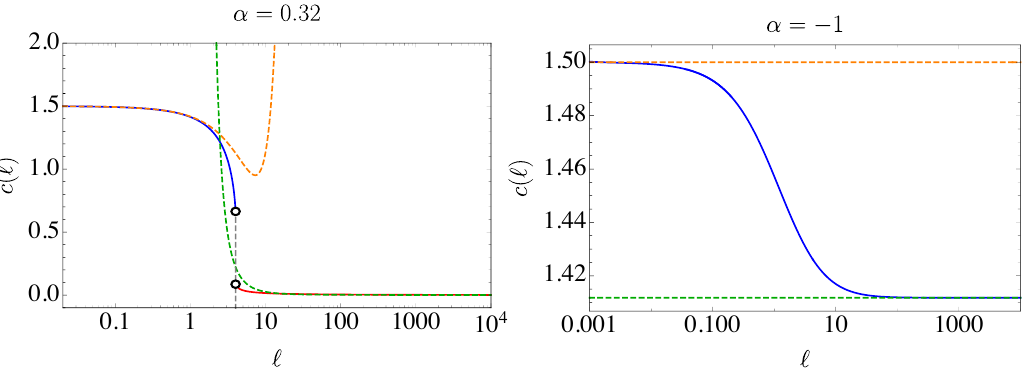
Figure 4 . Left plot: Casini-Huerta c -function for α = 0 . 32 . Blue and red solid lines: short and long RT surfaces on left and right hand sides of kink at ‘ ∗ . Orange and green dashed lines: perturbative results for small (5.11) and large (5.12). Right plot: Casini-Huerta c -function for α = − 1 . Blue solid: numerical result. Orange dashed line: UV result, c UV = 3 / 2 . Green dashed line: IR result (5.14), c IR = 24 / 17 ≈ 1 . 41 .